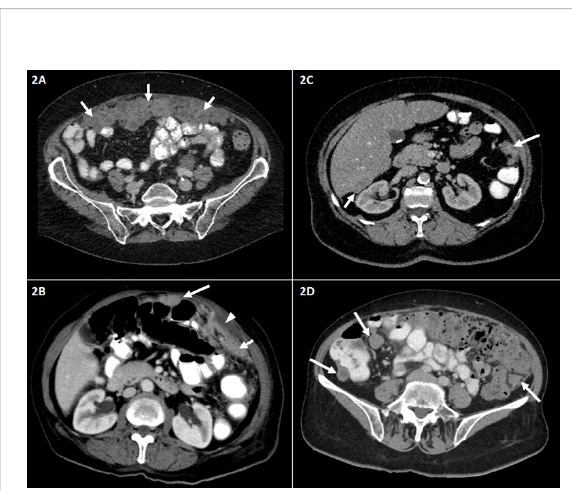
FIGURE 2 Representative abdominal CT fi ndings in patients with advanced ovarian carcinoma FIGO stage III – IV. Axial contrast-enhanced CT scans of the middle and lower abdomen (A – D) . (A) Irregular soft tissue mass representing large omental plaques called omental cake (short arrows) common site of intraperitoneal seeding of ovarian carcinoma. (B) Peritoneal thickening (short arrow) and small amount of ascites (arrowhead). Peritoneal nodule adjacent to the transverse colon (long arrow). (C) Peritoneal nodules in the left paracolic gutter (long arrow) and the hepatorenal recess (Morison ’ s pouch) (short arrow). (D) Peritoneal implants/nodules in the right and left paracolic gutter. FIGO, International Federation of Gynecology and